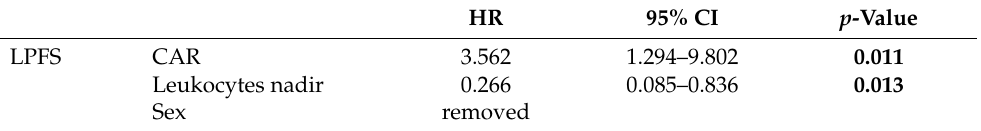
Table 3. Multivariate Cox regression